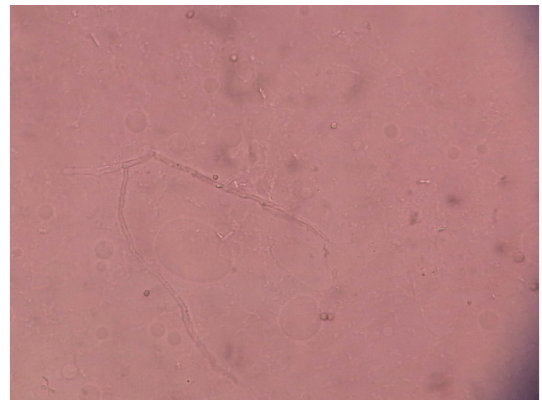
Figure 2: KOH mount revealing the septate fungal hyphae with the characteristic dichotomous branching, when observed under a 40X Olympus CX21 compound microscope.